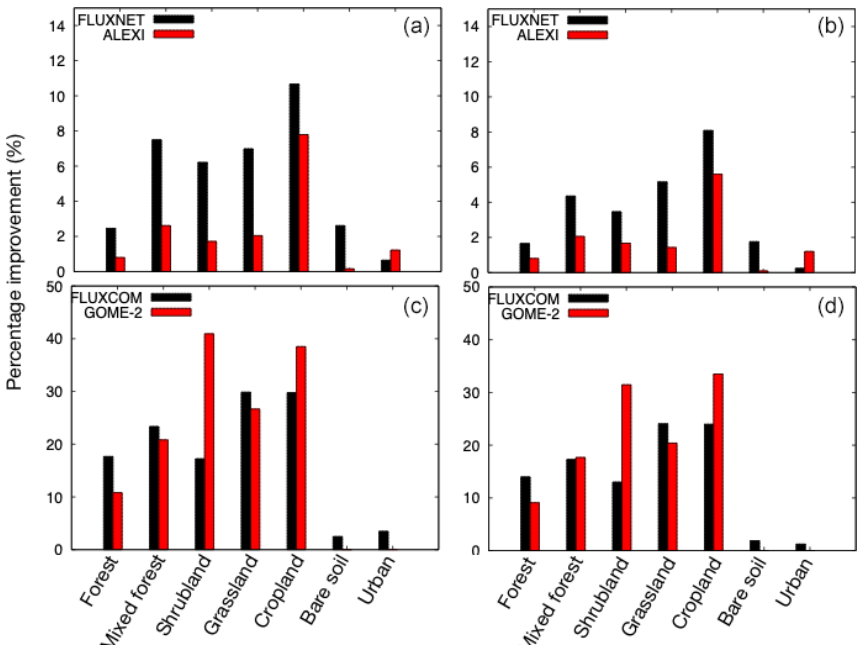
Figure 5. Domain-averaged percentage improvements in ET (a, b) and GPP (c, d) stratified by vegetation type. Panels (a, c) represent the impact of DA from X-band VOD, whereas panels (b, d) represent the impact of C-band VOD DA. The percentage improvements in ET using the FLUXNET and ALEXI reference datasets are expressed for the RMSE and R metrics, respectively. Similarly, the percentage improvements in GPP using FLUXCOM and GOME-2 SIF are for the RMSE and R metrics,